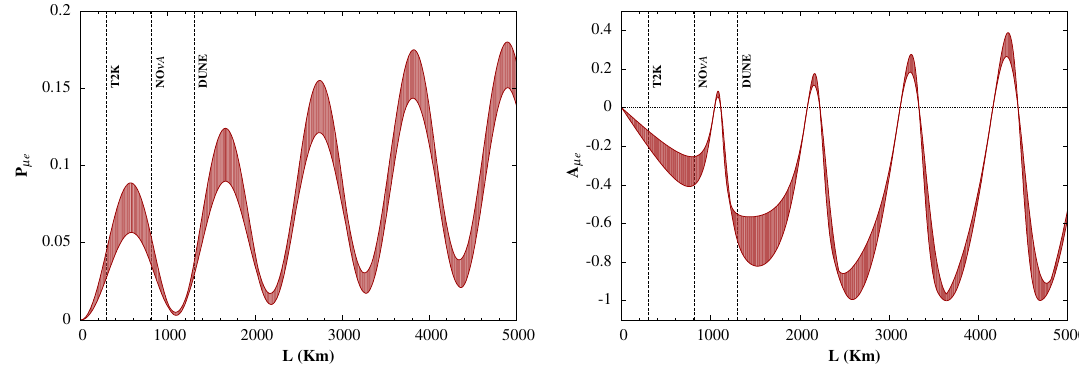
Figure 3 . Variation of the transition probability ( P (cid:22)e ) and CP asymmetry parameter ( A (cid:22)e ) against the baseline length L for IO ( E = 1 GeV). The plots are for (cid:14) = 3 (cid:25)= 2 and the bands correspond to 3 (cid:27) ranges in (cid:18) 12 and (cid:18) 13 . The three vertical dashed lines indicate observations at three di(cid:11)erent baseline lengths: L = 295Km for T2K, L = 810Km for No (cid:23) A and L = 1300Km for DUNE. CP is conserved along the horizontal dotted line A (cid:22)e = 0.